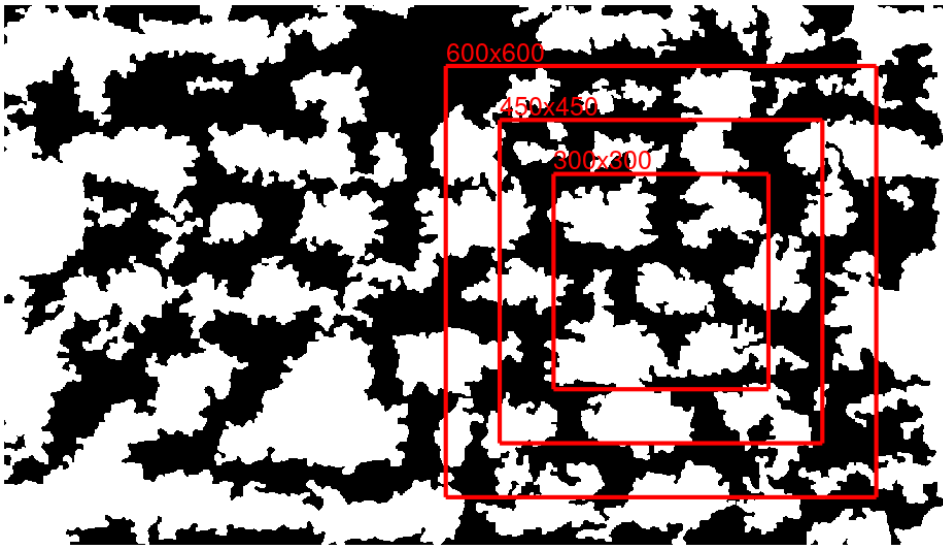
Figure 14. Test-windows used for the estimation of elastic characteristics of the masonry